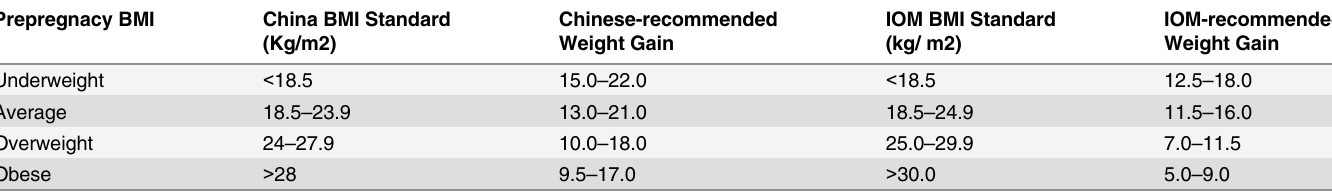
Table 2. The differences between IOM and Chinese-recommended weight gain by BMI Categories. Prepregnacy